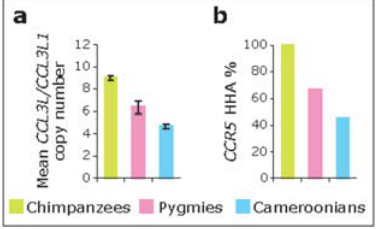
The prevalence of the chimpanzee CCR5 HHA haplotype and the ortholog of human CCL3L1 in chimpanzee designated as CCL3L [20], is also shown (N=83). Error bars in panel a denote 95% confidence